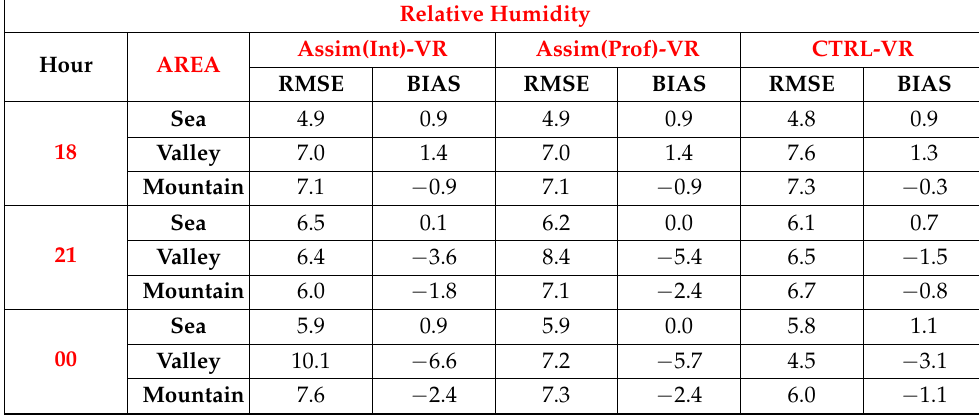
Table A2. As in Table A1, but for relative humidity (RH).